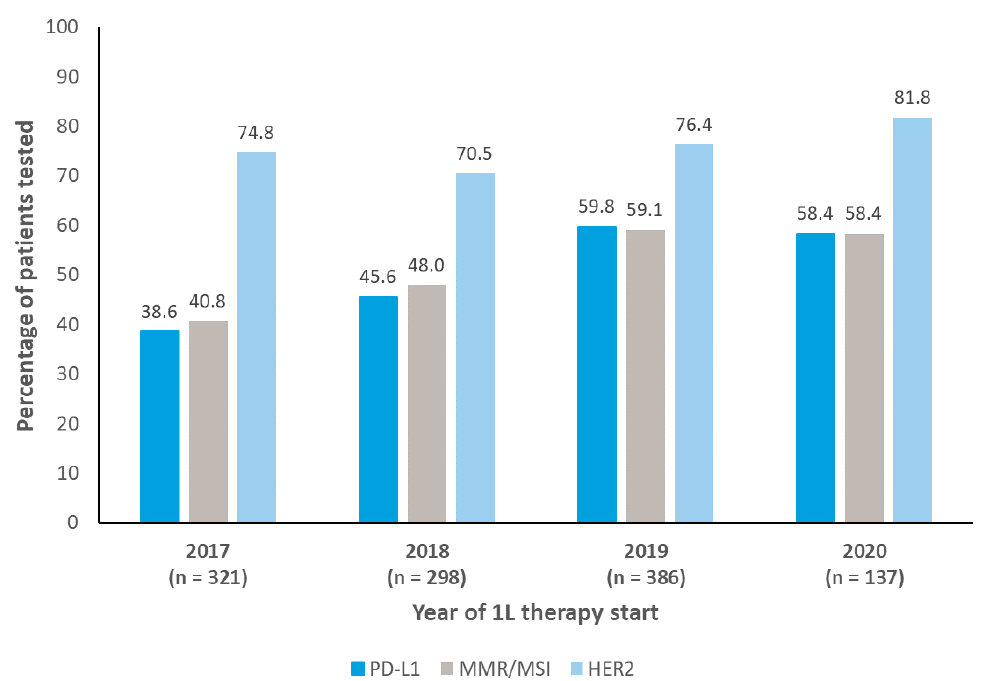
Figure 1 . Biomarker testing by year of 1L therapy start. 1L, first-line. HER2, human epidermal growth factor receptor 2. MSI, microsatellite instability. MMR, mismatch repair. n, number of patients tested. PD-L1, programmed cell death-ligand 1. The median (IQR) time from initial GEC diagnosis to first biomarker test was 0.6 (0 –